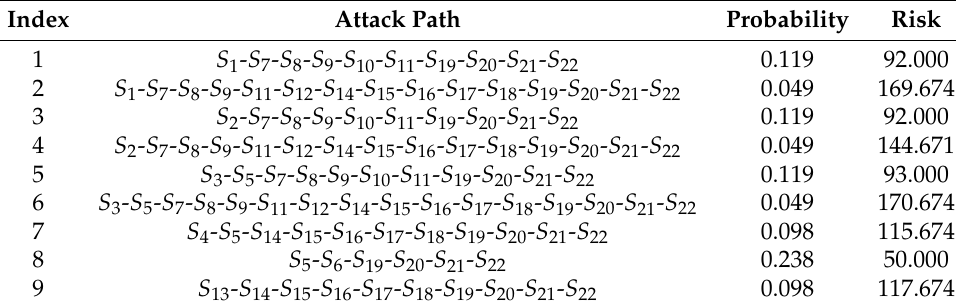
Table 8. Path reachability probability and path risk